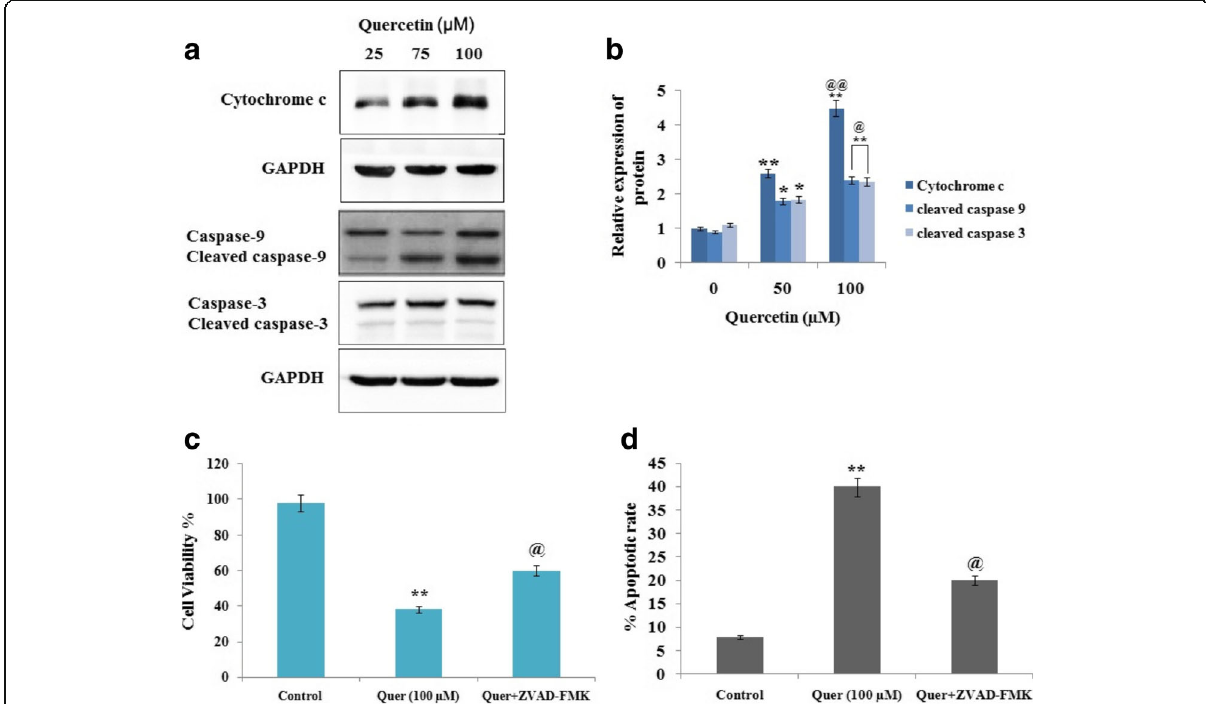
Fig. 4 Quercetin causes apoptosis of cancerous RB Y79 cells via intrinsic pathways. a and b The Y79 cells were exposed to Quercetin (0-100 μ M). The obtained cell lysates after 24 h were analyzed by western blot using specific antibodies against caspase-9, caspase-3 and cytochrome c , GAPDH was used as a loading control. * P <0.05, ** P <0.01 against control ( n =3). @ P <0.05, @@P<0.01 against Quercetin 50 μ M. c Y79 cells were exposed to 100 μ M Quercetin for 24 h in the presence or absence of ZVAD-FMK. Viability of cells was done by the Cell Counting Kit-8, the data are presented as the percentage of control cells, means ± SD ( n =3), ** P <0.01 against control, @P<0.05 against Quercetin treated group. d Quercetin exposed apoptosis was blocked by ZVAD-FMK treatment, the data presented are means ± SD ( n =3). ** P <0.01 against control, @ P <0.05 against Quercetin treated